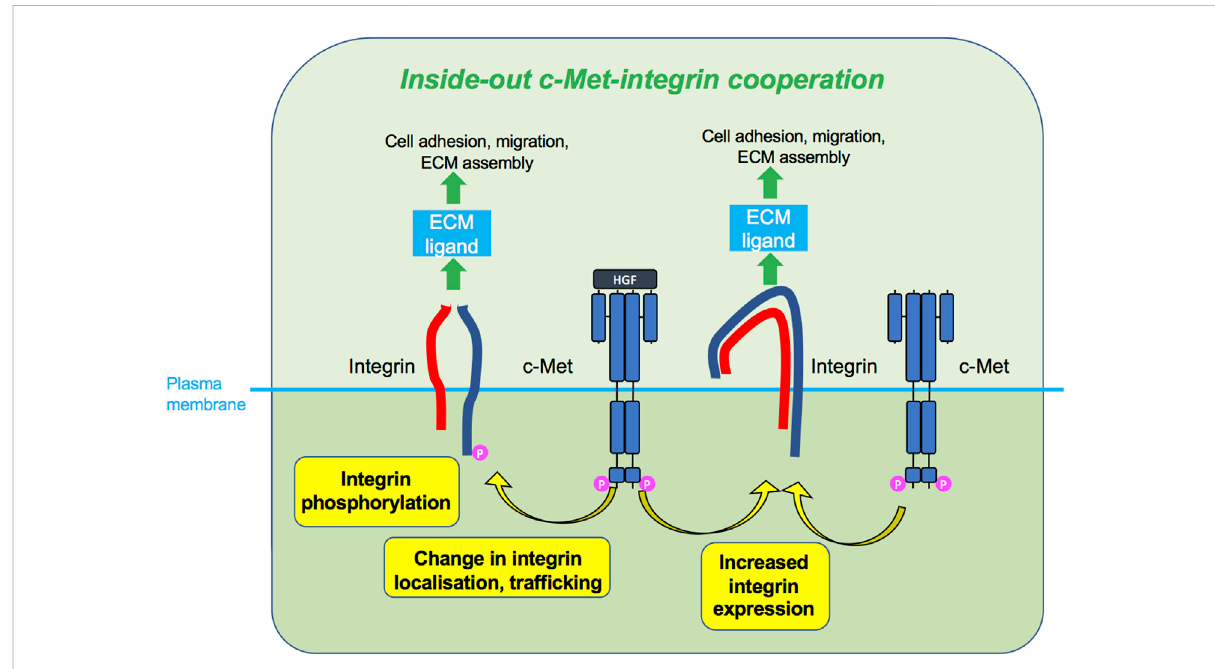
FIGURE 5 Inside-out c-Met-integrin cooperation. c-Met, upon HGF stimulation or sometimes without HGF, promotes integrin activity, such as phosphorylation, increased expression or change in localisation. Activated integrins can in turn bind ECM ligand and induce cellular responses such as adhesion and